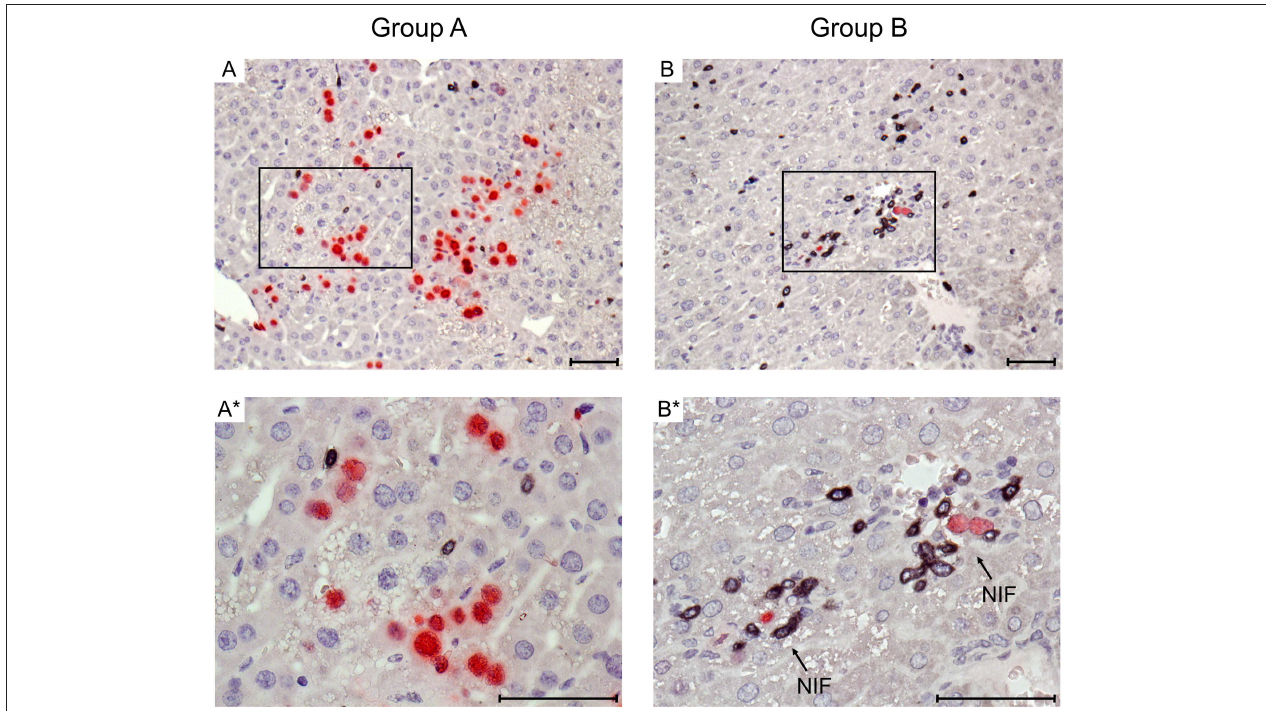
FIGURE 2 | Immunohistological images of liver tissue infection and infiltration by T cells. Representative 2C-IHC images of liver tissue sections taken on day 14 after HCT and infection, corresponding to the infection load data shown in Figure 1B . (Red IHC staining) IE1 protein in nuclei of infected liver cells, which are predominantly hepatocytes. (Black IHC staining) CD3 ε protein expressed by T cells. (Group A) No therapy. (A) Overview. (A*) Detail. (Group B) Therapy by transfer of CTL. (B) Overview. (B*) Detail. Frames in images (A,B) point to regions resolved to greater detail in images (A*,B*) , respectively. Light counterstaining was done with hematoxylin. NIF (arrows in B* ): nodular inflammatory foci that represent microanatomical structures where transferred CTL (black) congregate at infected liver cells (red) to prevent intra-tissue virus spread. Bar markers: 50 µ m.